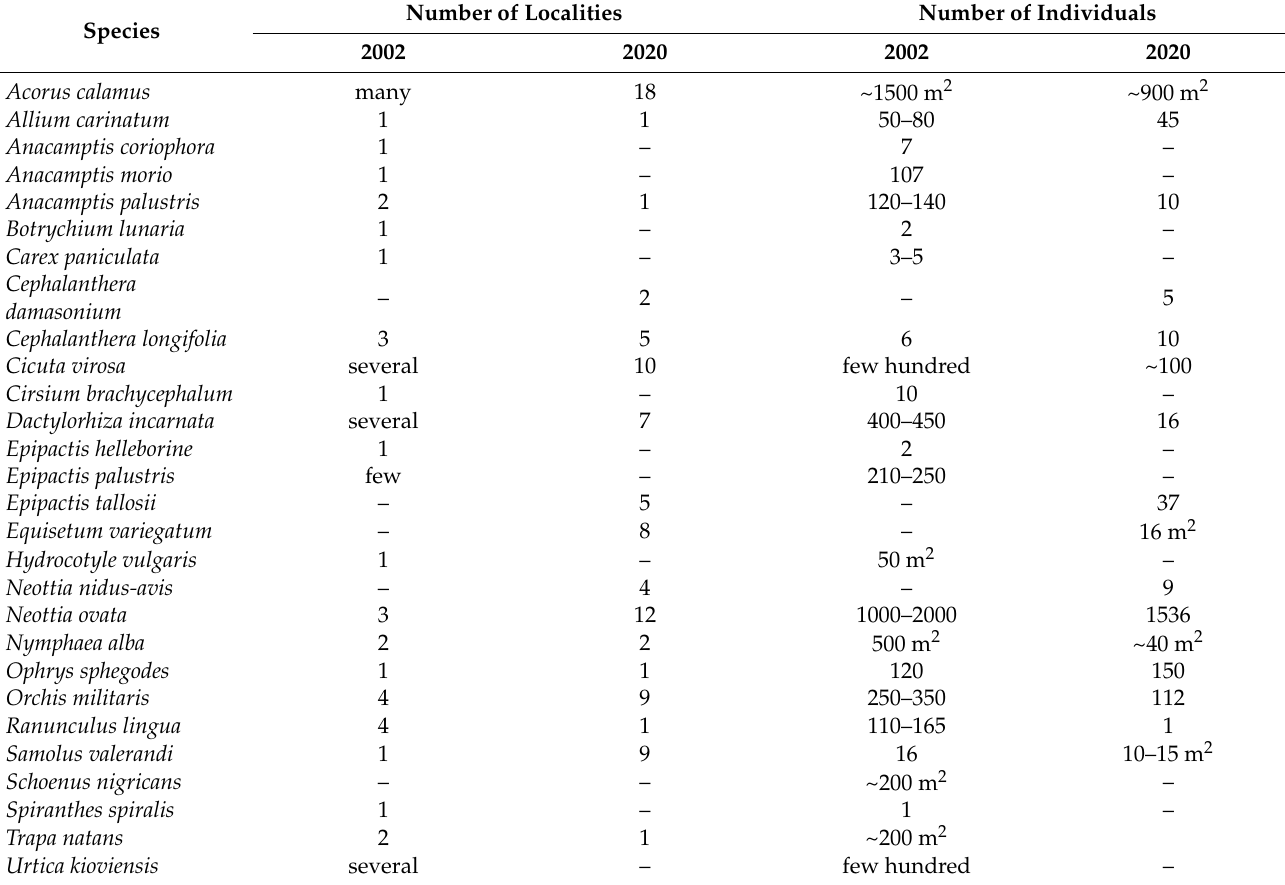
Table 3. The number of localities and individuals of protected plant species in 2002 and 2020. Number of Localities Number of Species